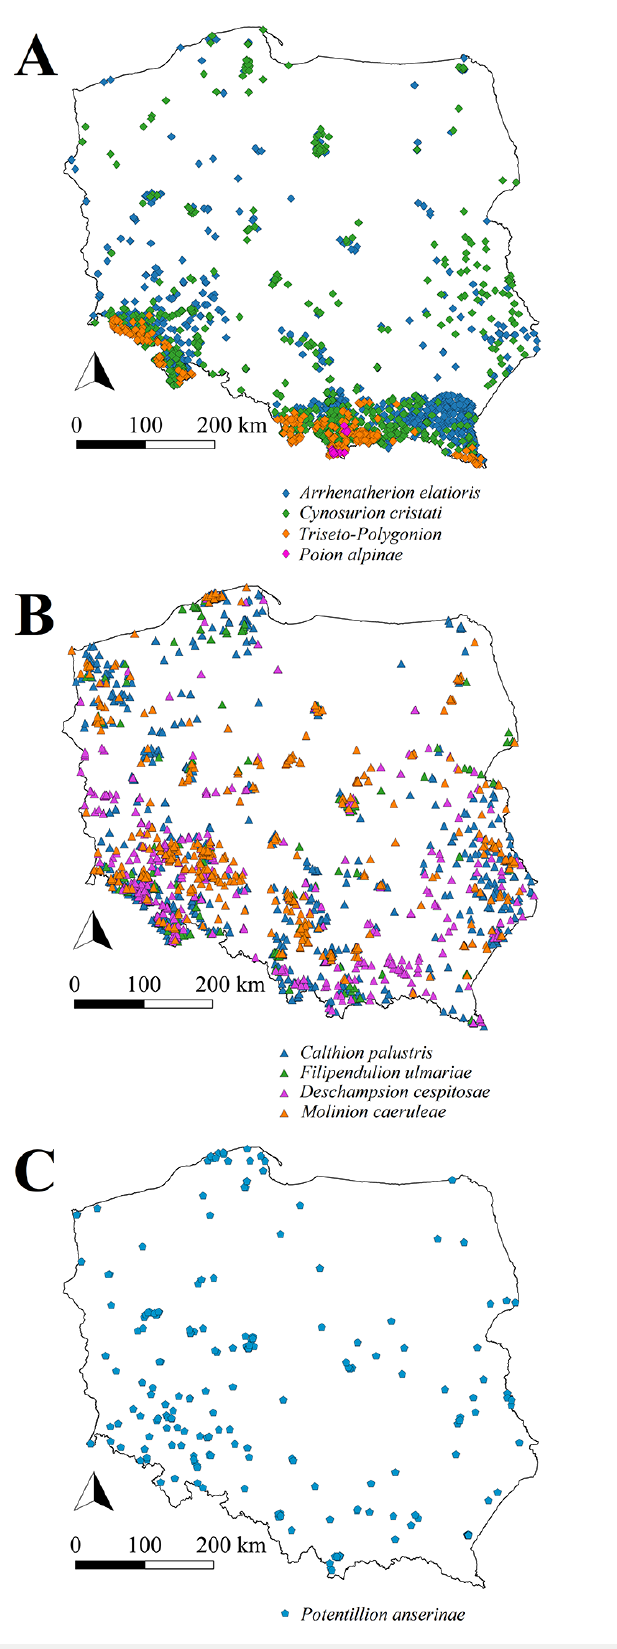
Figure 1 Distribution of relevés representing alliances from the order Arrhenatheretalia ( A ), Molinietalia ( B ), and Potentillo- Polygonetalia ( C